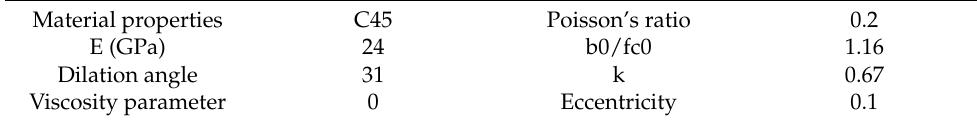
Table 2. Properties of the material used in numerical